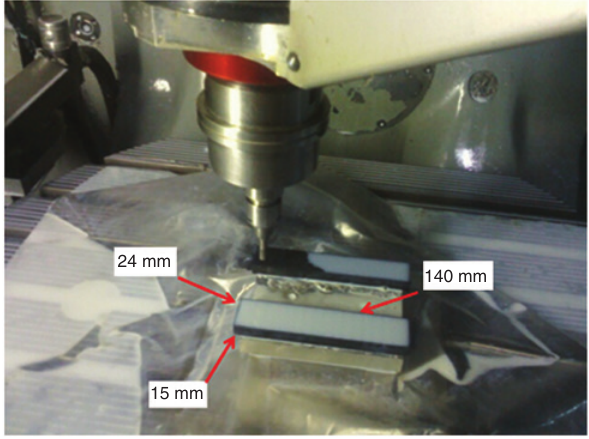
Figure 1: Experimental setup.